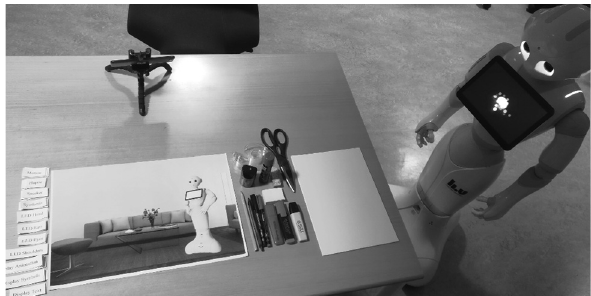
Figure 6: The session setup. In the middle of the table facing the participant is the shared design surface. On the left side are the prede fi ned labels. On the right side are creative tools. On the top of the table is the camera facing the shared design surface. On the side of the table is a